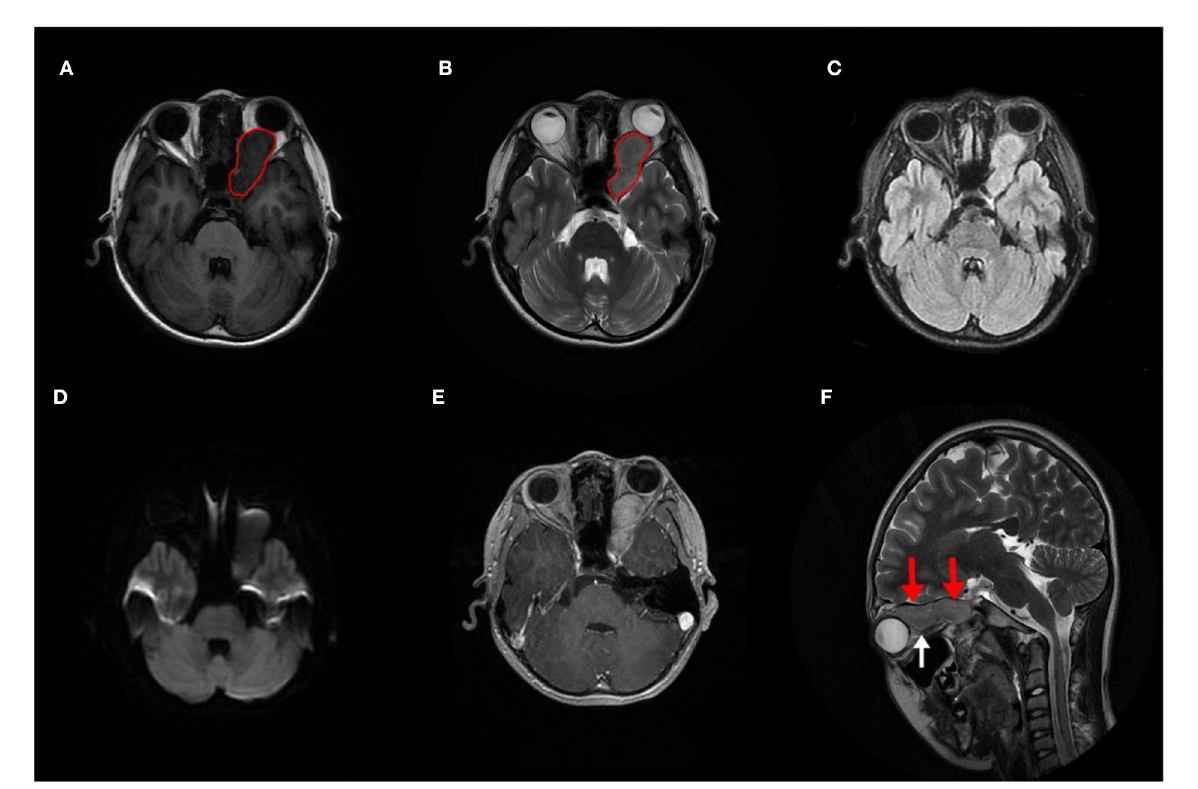
FIGURE2 Preoperative image of magnetic resonance imaging (MRI). (A–D) MRI demonstrating a circumscribed mass that extended into the left cavernous sinus (red circle), with a slightly inhomogeneous hypointense signal on T1WI and a slightly inhomogeneous hyperintense signal on T2WI. Meanwhile, it shows an inhomogeneous isointense signal on fluid-attenuated inversion recovery (FLAIR) and a hypointense signal on diffusion-weighted imaging (DWI). (E) The mass showed clear and mild inhomogeneous enhancement after Gd injection. (F) The mass located above the optic nerve (red arrows), which was intact and not pressed (white